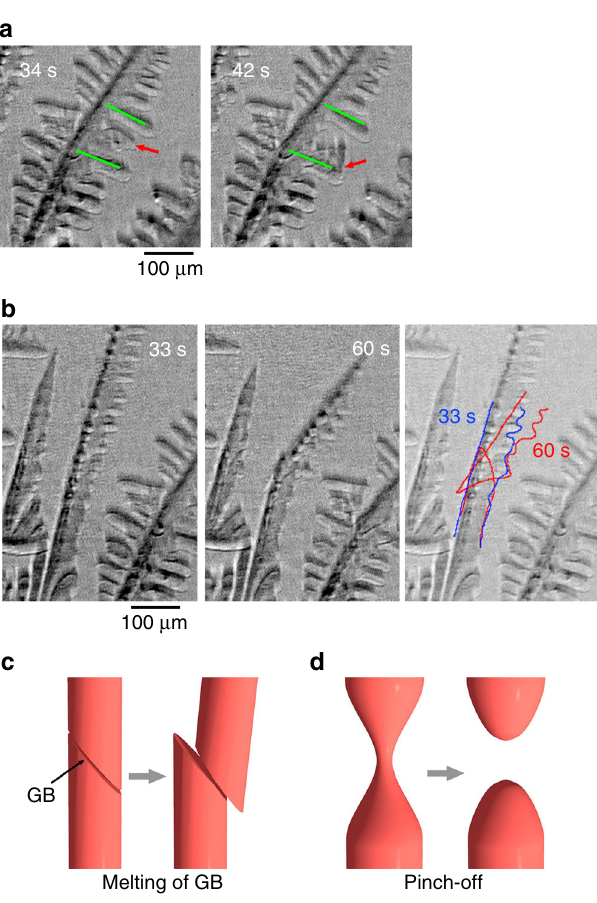
Fig. 3 Close-up views of fragmentated arms. a Fragmentation of the secondary dendrite arm in 0.58 C steel. The secondary arm that is indicated by a red arrow between the secondary arms that are indicated by green lines was fragmented between 34 s and 42 s and settled down because of the gravitational force. b Fragmentation of the primary dendrite arms in 0.58 C steel. The fragmented arm was tilted because of the gravitational force. Blue and red lines indicate the solid – liquid interface at 33 s and 60 s, respectively. c Schematic diagram of dendrite arm fragmentation at the γ grain boundary and the δ – γ interface in Fe – C alloys. d Schematic diagram of fragmentation caused by the pinch-off